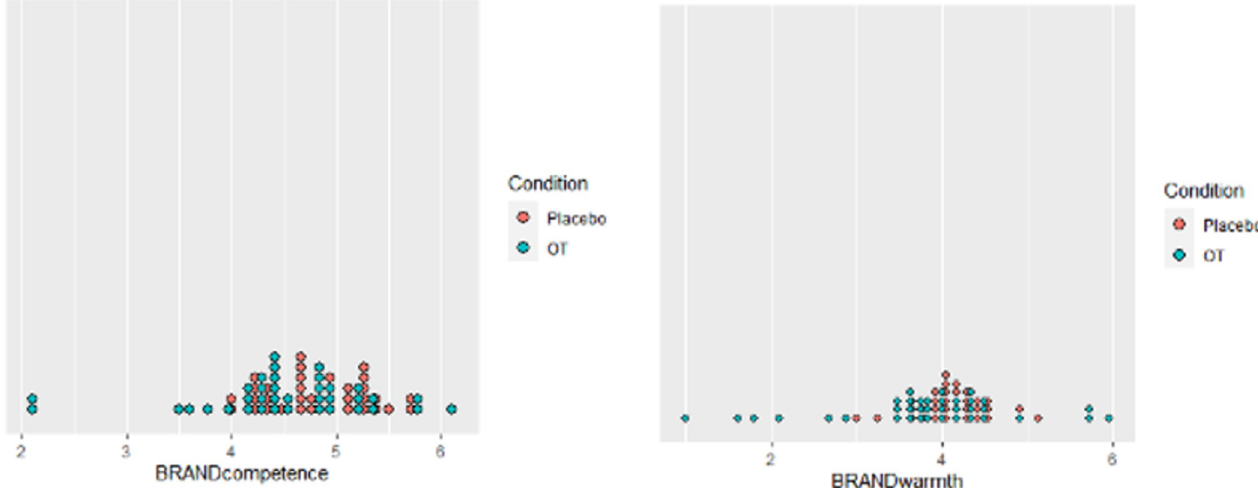
Fig 1. The distribution of brand competence and warmth by condition. The change in competence after brand exposure was 132% higher for OT compared to placebo (17.6% vs. 7.6%; p = .05).